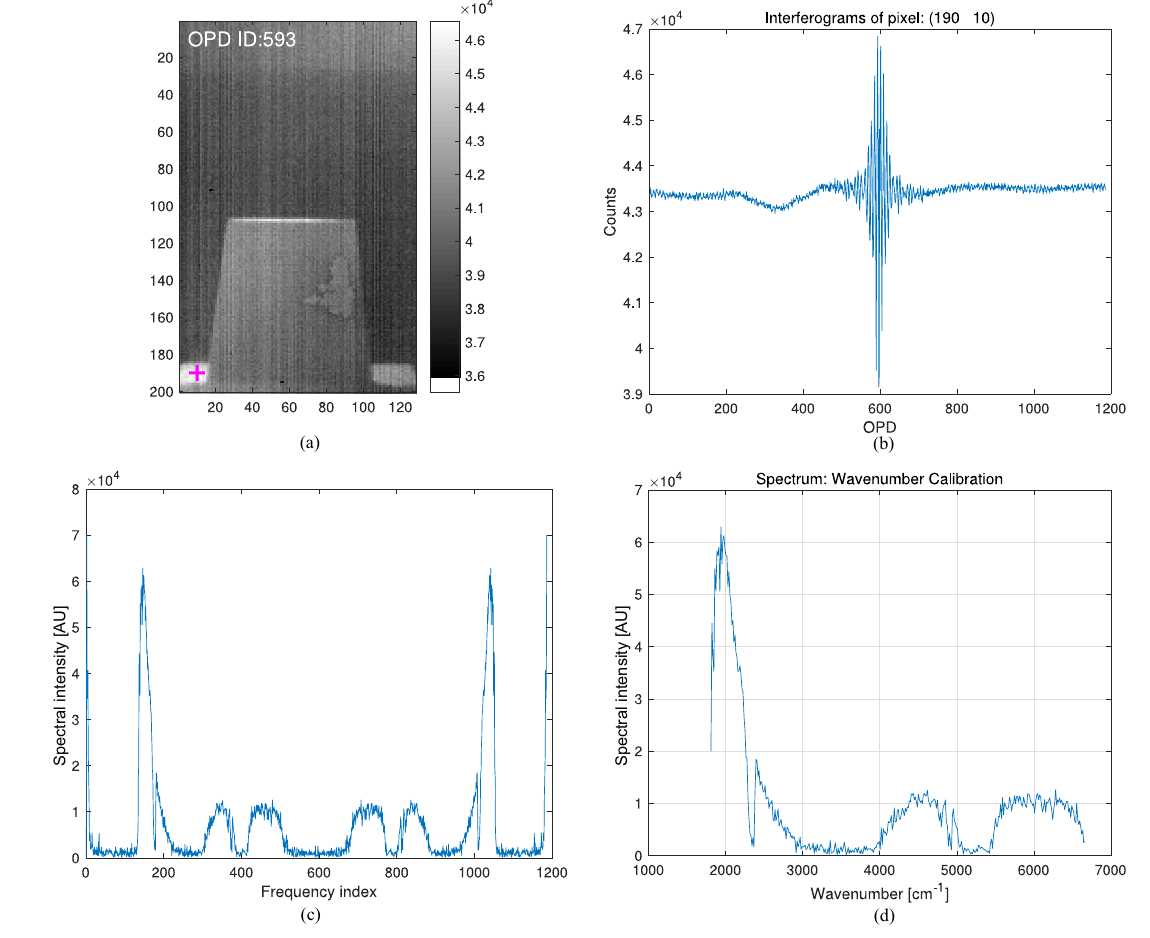
Figure 3. Spectral calibration process: ( a ) interferogram image at optical path difference (OPD) ID = 592 (ZPD); ( b ) interferogram at a pixel ((row, col) = (190, 10)); ( c ) fast Fourier transform (FFT) results; ( d ) wavenumber calibration